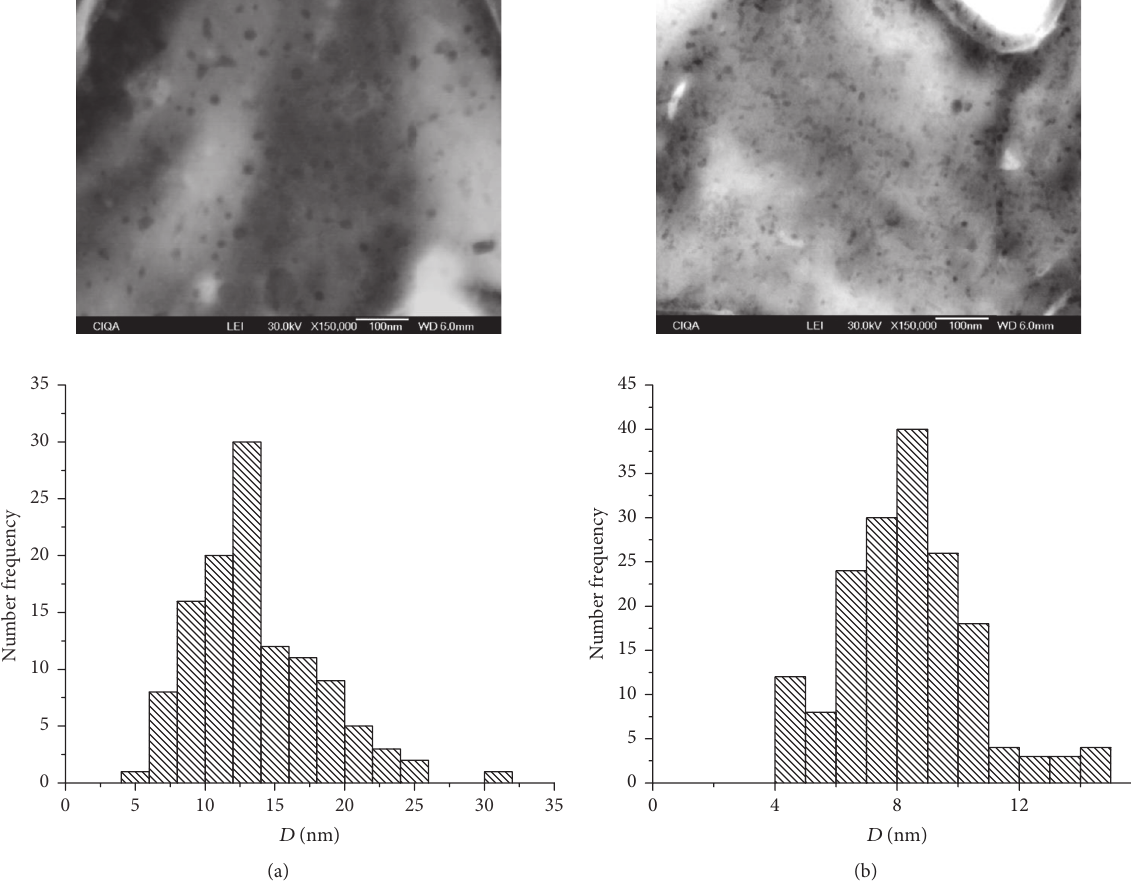
Figure 3: Micrographs of latex samples taken at different global conversions in a copolymerization of MMA/MAA (2/1, mol/mol): (a) 36.3 and (b) 92.6%.